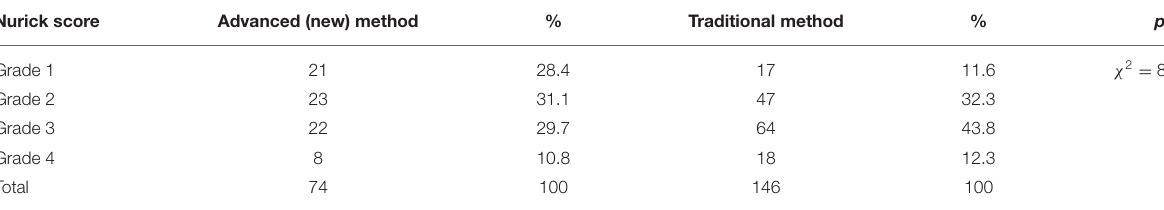
TABLE 2 | Results of surgical treatment of extramedullary tumors.